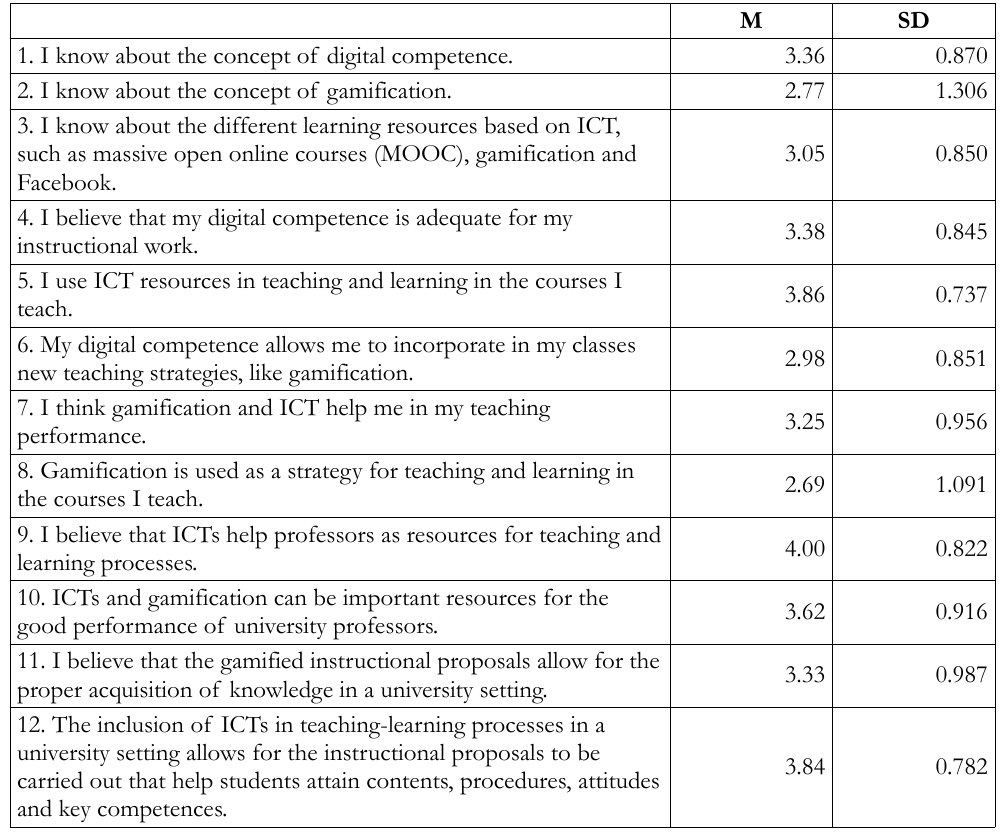
Table 2. Descriptive statistics (M=mean and SD=standard deviation) of the perception of the digital competences and gamification in instruction